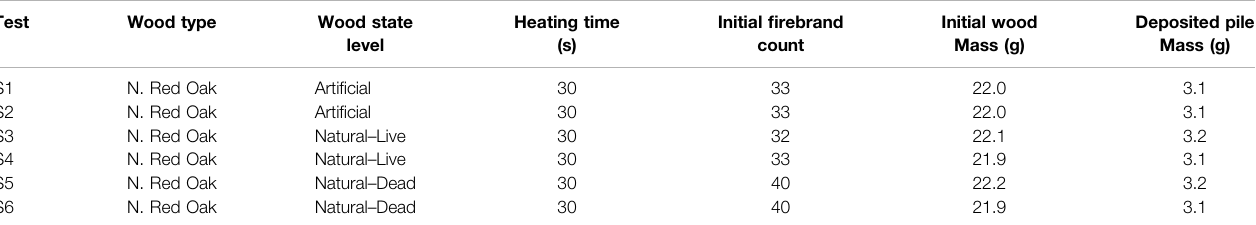
TABLE 5 | Test matrix used to assess the effect of fi rebrand wood state on the heat transfer from fi rebrand piles. Firebrand diameter 9.5 mm, length 12.5 mm, and MC 0% with wind speed 2.0 m/s.